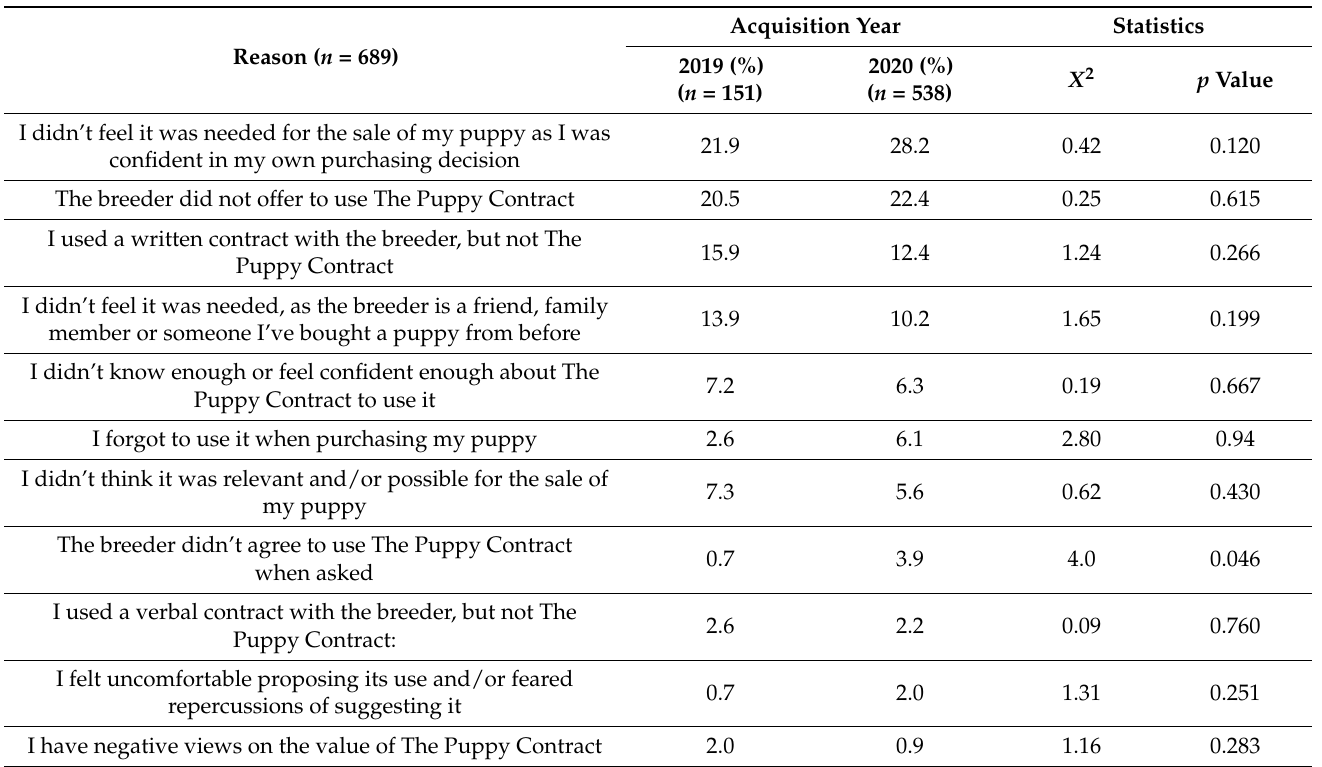
Table 14. Reasons owners chose not to or were unable to use The Puppy Contract during their puppy purchase with comparison between 2019 puppy owners ( n = 151) and Pandemic Puppy owners ( n = 538) in the UK.